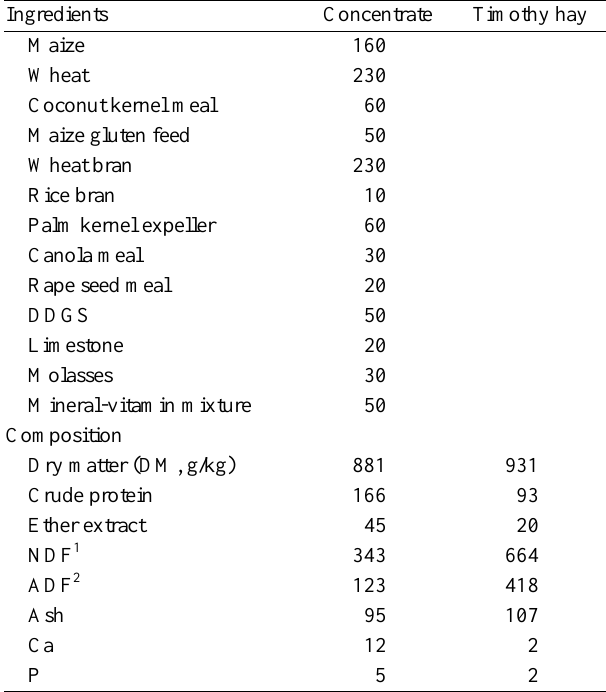
Table 1. Ingredients of the concentrate (g/kg) and composition (g/kg dry matter unless stated) of concentrate and timothy hay